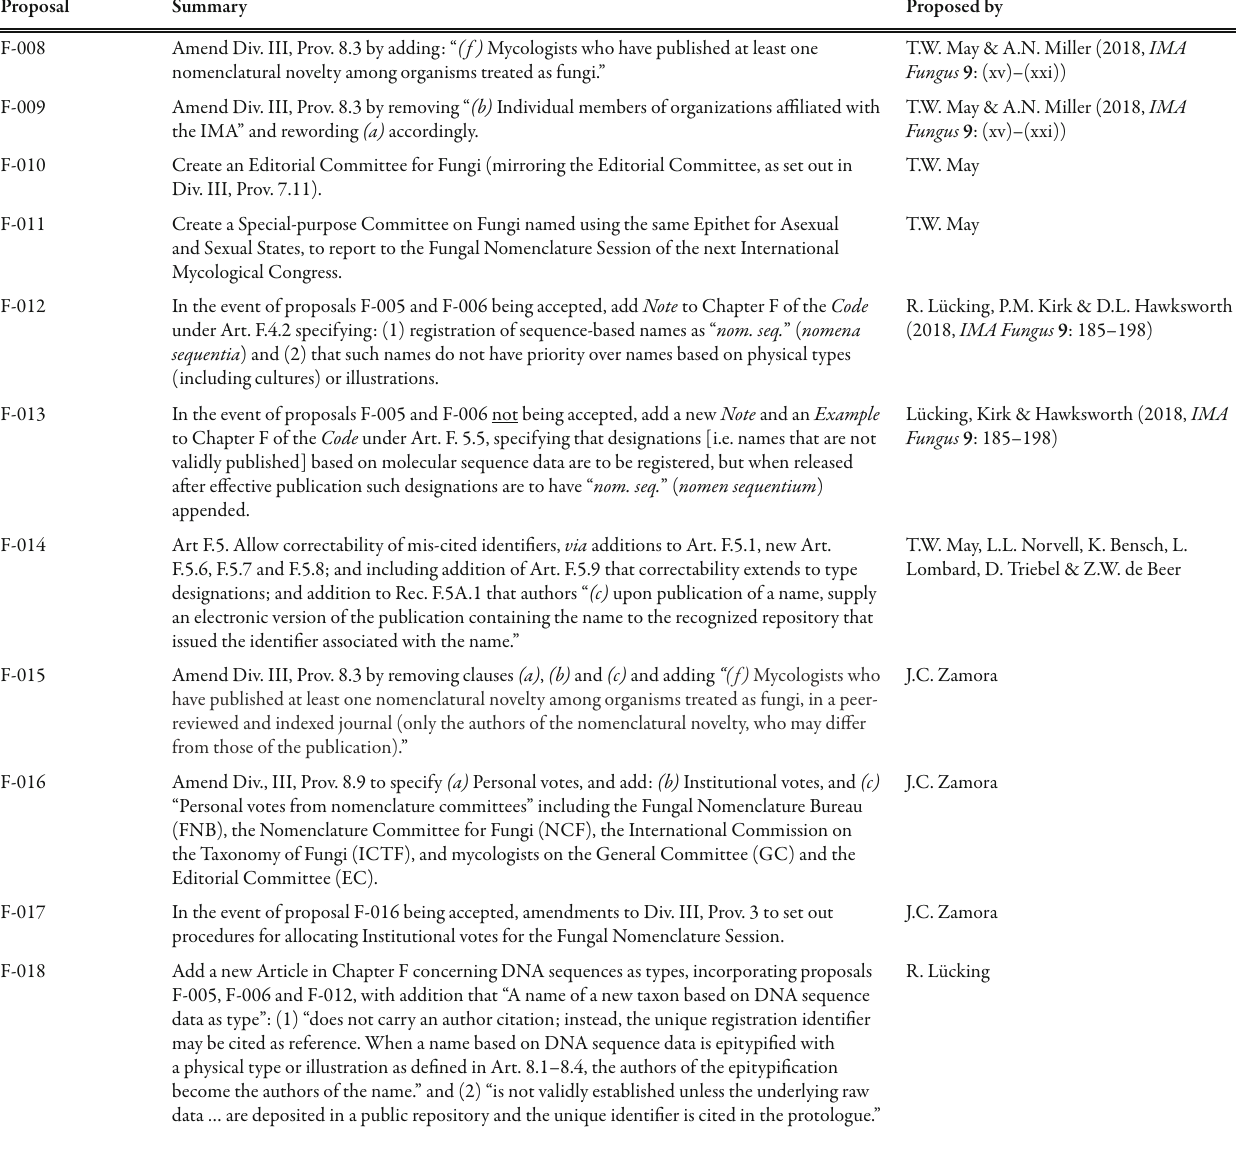
Table 1. Proposals “from the floor” dealt with at the IMC11 Fungal Nomenclature Session. Proposal